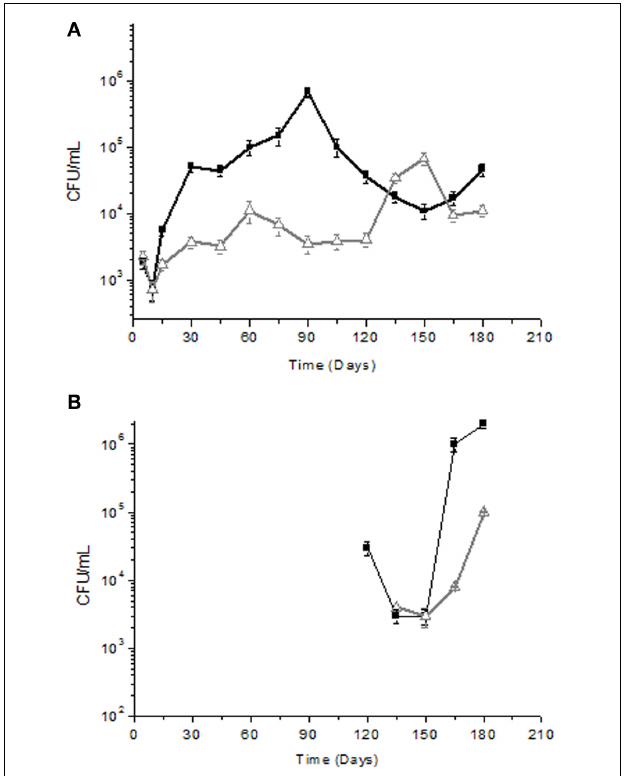
FIGURE 1 | Yeast (A) and LAB (B) total counts (Log CFU/ml) of Cellina di Nardò and Leccino naturally fermented table olives. Detection limit ± 10 cfu/ml. LAB were not detected during the period of time between 15 and 120 days of